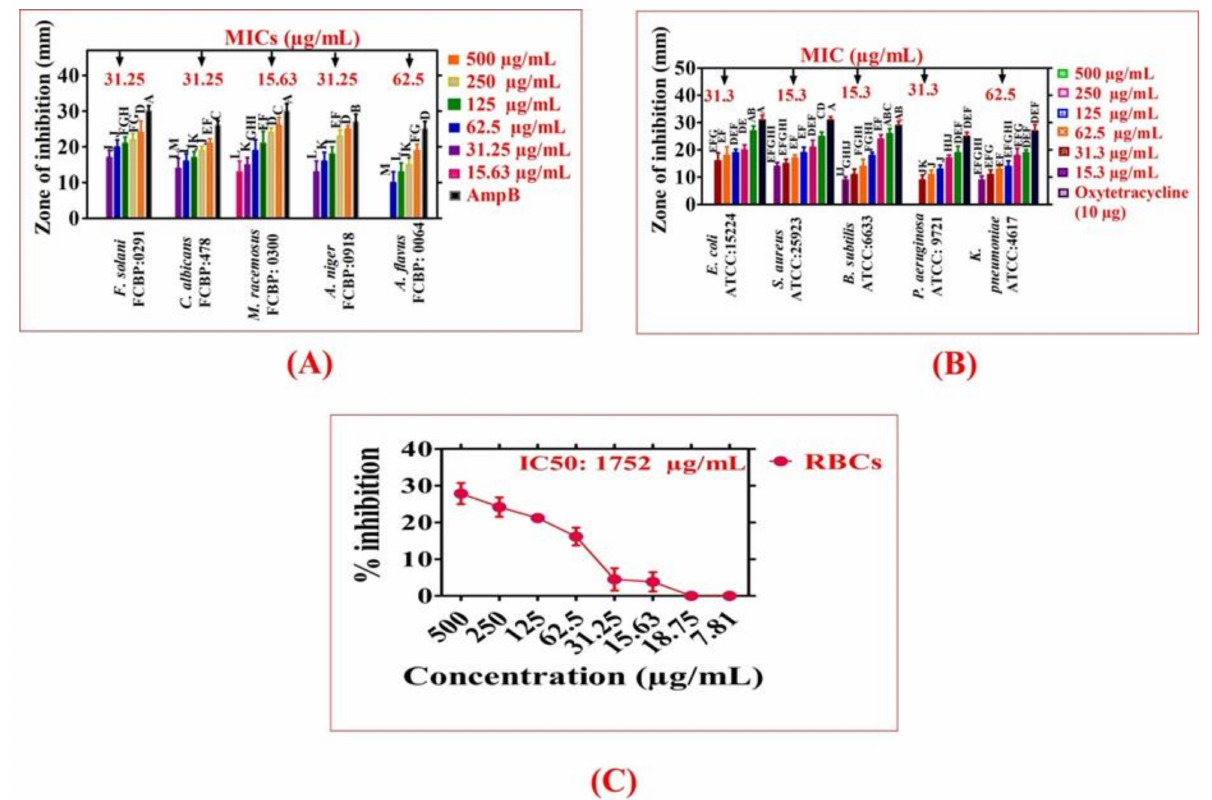
Figure 6. Antimicrobial and Biocompatibility assays for ElA-NiONPs; ( A ) Antifungal assay; ( B ) An- tibacterial assay; ( C ) Biocompatibility studies. Data represent the mean of three replicates, and each alphabet indicates significance at p <